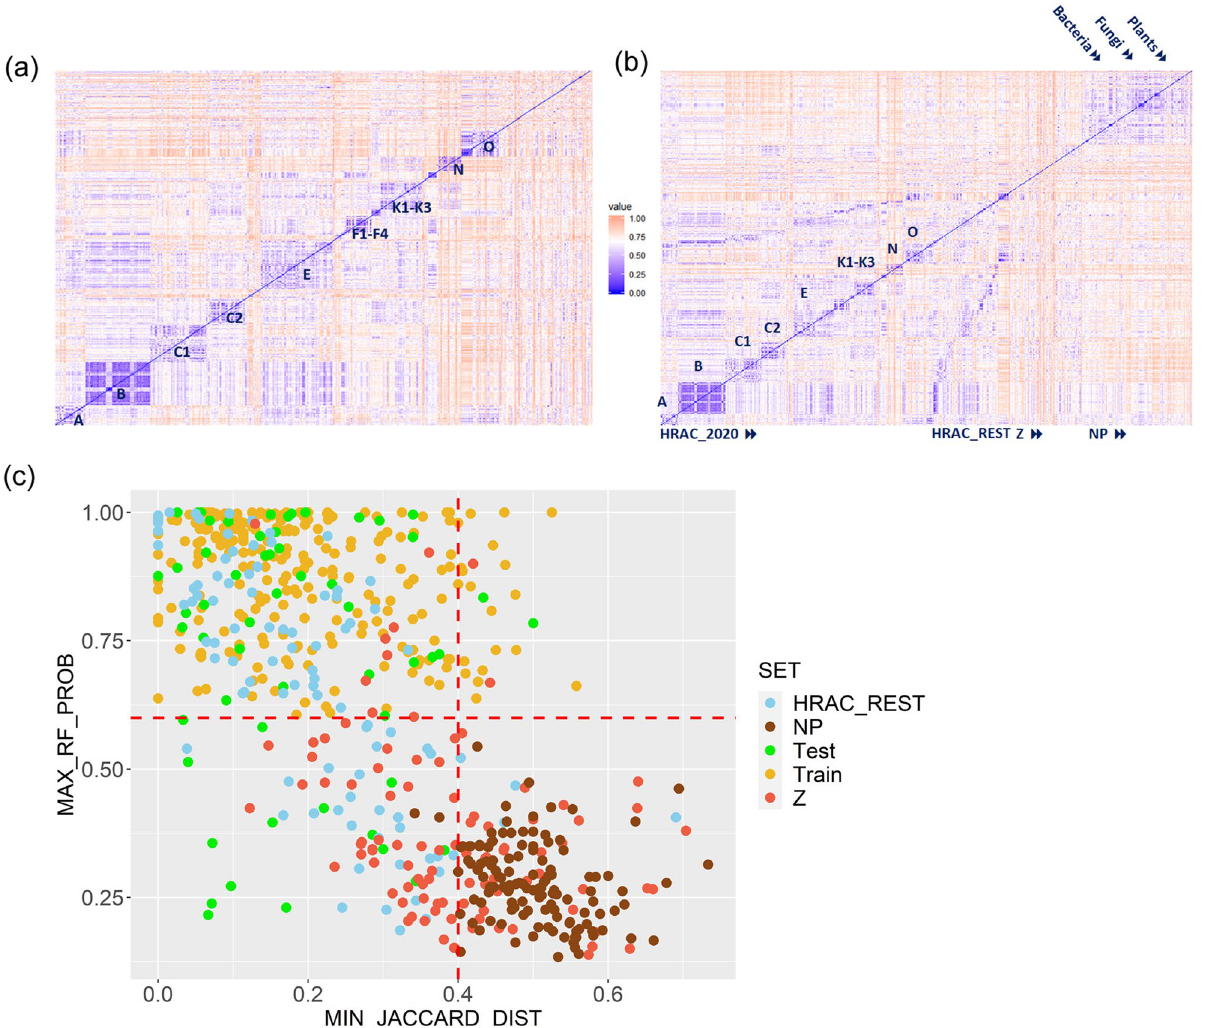
Figure 3. Heat maps for structural dissimilarity quantified by Jaccard coefficient(1-TC) calculated for all pairs of 509 synthetic herbicides ( a ) arranged into MoA classes and ( b ) divided into the subsets HRAC2020, HRAC_ REST and the Z compounds with addition of the set of NPs originated from bacteria, fungi and plants. The extended, HRAC2020 and HRAC_REST compounds are ordered according to the classes A-P. More blue/red values correspond to more structurally similar/diverse compounds. ( c ) Definition of AD for the RF MoA model (Table 2): given a compound, the model’s prediction is considered reliable if it is similar to at least one training herbicide with TC greater than 0.6 and the estimated class probability is greater than